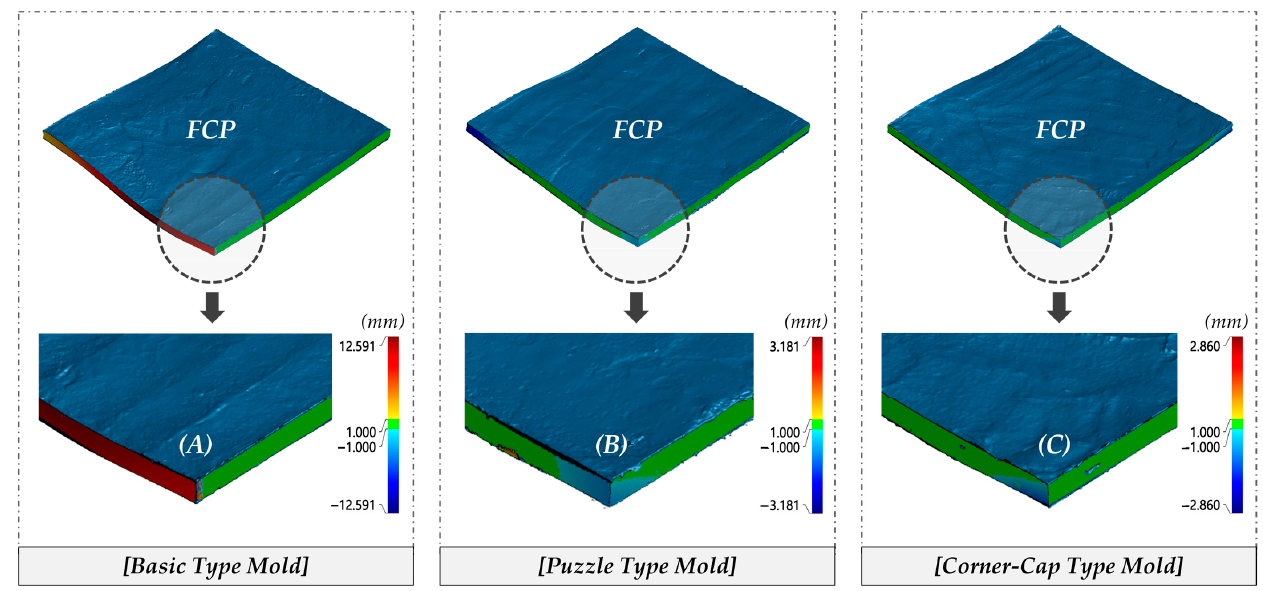
Figure 7. Scanning